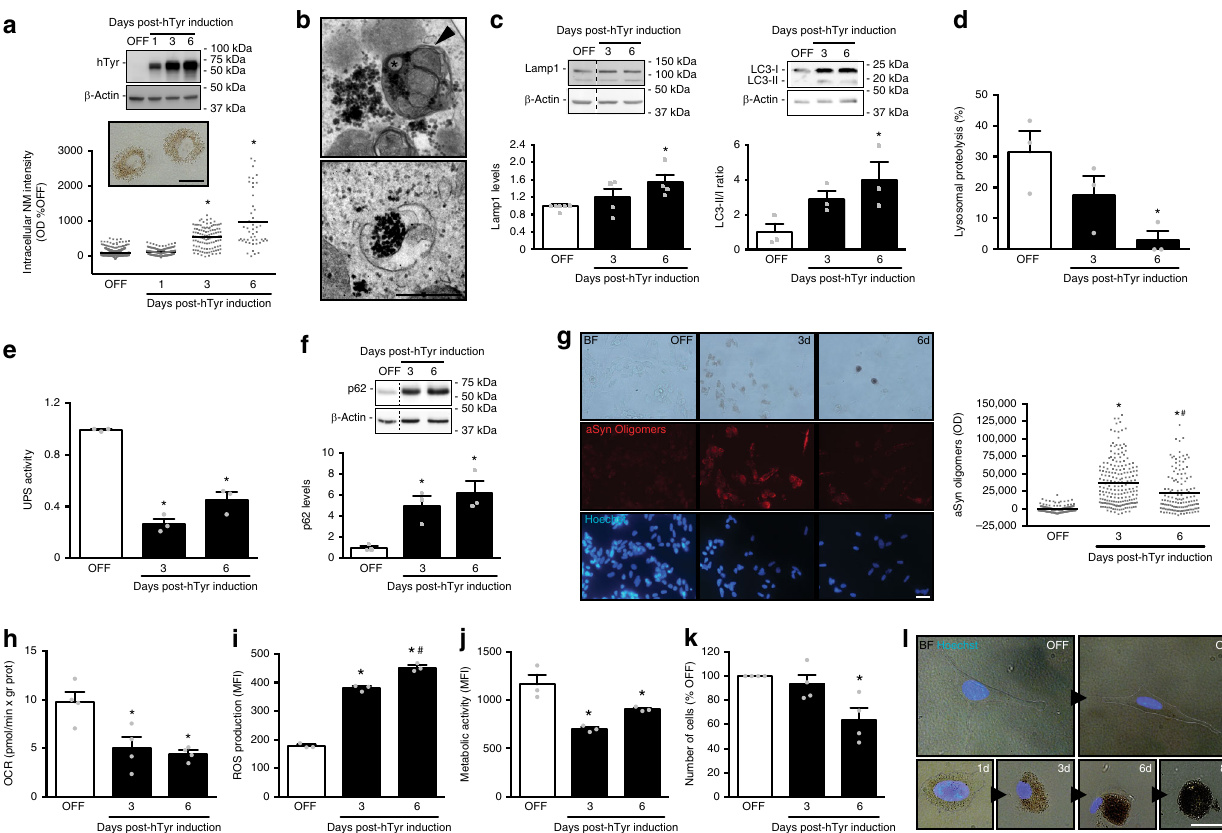
Fig. 8 General proteostasis failure in NM-producing cells. a Top, Induction of hTyr expression in differentiated neuroblastoma SH-SY5Y cells before (OFF) and after (ON) treatment with doxycycline. Bottom, quanti fi cation of intracellular NM optical density post-hTyr induction. * p < 0.05, compared to OFF and ON 1d (ANOVA on ranks; Dunn ’ s post-hoc test). Scale bar, 12.5 μ m. b Electron micrographs of NM granules in hTyr-expressing cells (6d post-hTyr induction). Arrowhead, double-membrane; asterisk, lipid droplet. Scale bar, 0.5 μ m. c Immunoblot levels of Lamp1 (left) and LC3 (right) post-hTyr induction. d Lysosomal proteolysis post-hTyr induction. e Ubiquitin-proteasome (UPS) activity post-hTyr induction. f Immunoblot levels of p62 post-hTyr induction. g Representative images (left) and quanti fi cation (right) of aSyn oligomers (red) in hTyr-expressing cells as detected by aSyn-proximity ligation assay. Hoechst, nuclei (blue). BF bright- fi eld. Scale bar, 25 μ m. h Mitochondrial oxygen consumption rate (OCR) post-hTyr induction. i ROS production post-hTyr induction. MFI mean fl uorescence intensity. j Cellular metabolic activity post-hTyr induction. k Number of surviving cells post-hTyr induction. l Representative bright- fi eld photomicrographs with superimposed nuclear Hoechst fl uorescent staining (blue) of hTyr-expressing cells before (OFF) and after (ON, 1 – 8d) hTyr induction. For clarity purposes, cell contour in weakly or no melanized cells are highlighted in white. Scale bar, 12.5 μ m. In all panels, values are mean ± SEM. In a , d , e and i , n = 3 independent experiments. In c , h , j and k , n = 4 independent experiments. In a (bottom), n = 499 (OFF), n = 155 (1d), n = 111 (3d), and n = 48 (6d) cells. In g , n = 153 (OFF), n = 201 (3d), and n = 135 (6d) cells. Immunoblot densitometry was